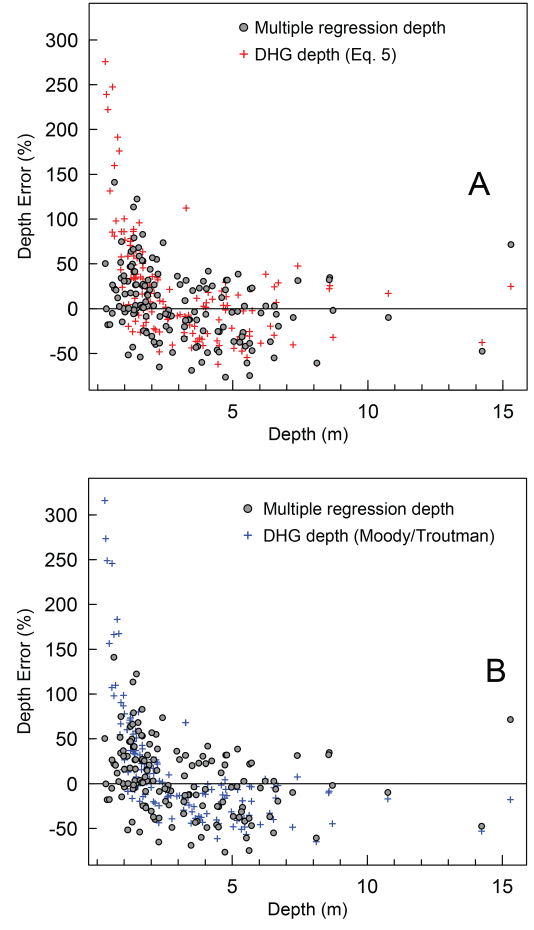
Figure 12. Relative depth error for multiple regression method (cir- cles) and (a) DHG estimate (this study) and (b) DHG estimate (Moody and Troutman,